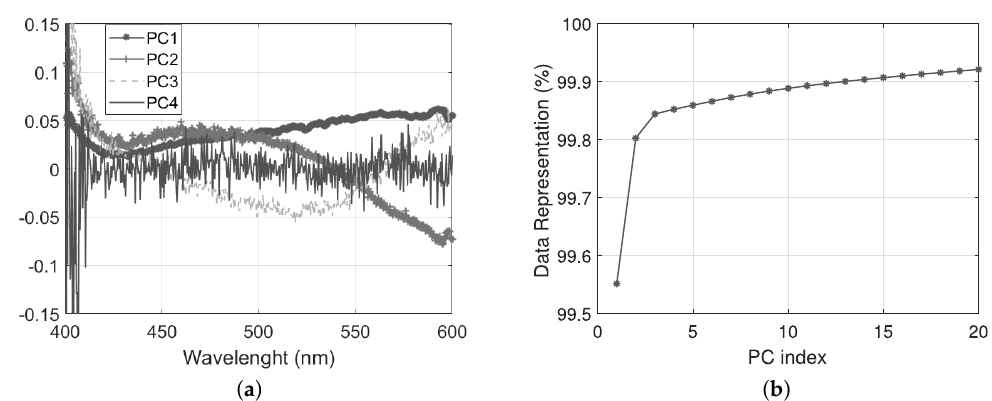
Figure 3. ( a ) First four principal components for referential ash reflectance data. ( b ) Accumulated variance by incrementing the number of principal components.